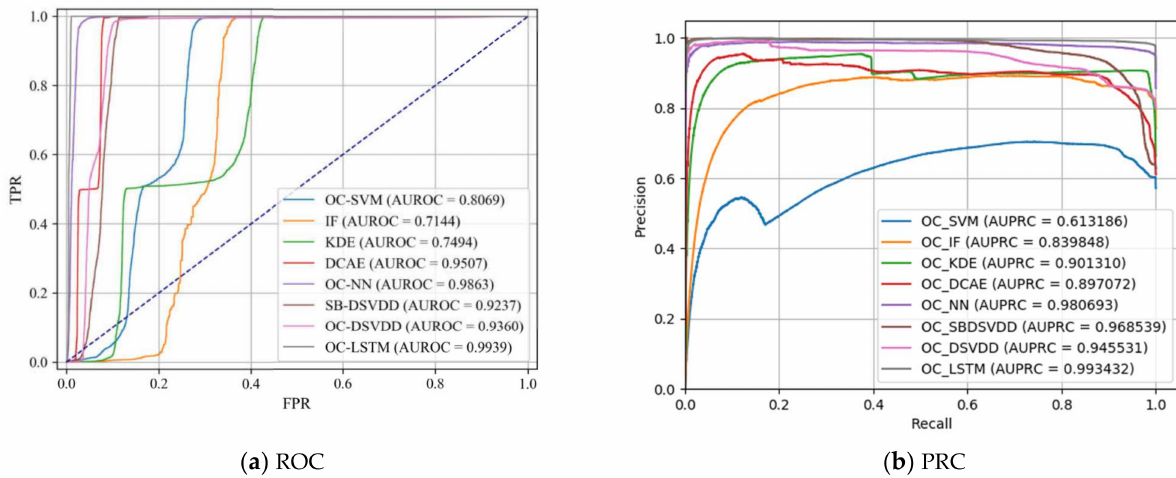
Figure 6. The ROC and PRC for each model on the CIC-PortScan